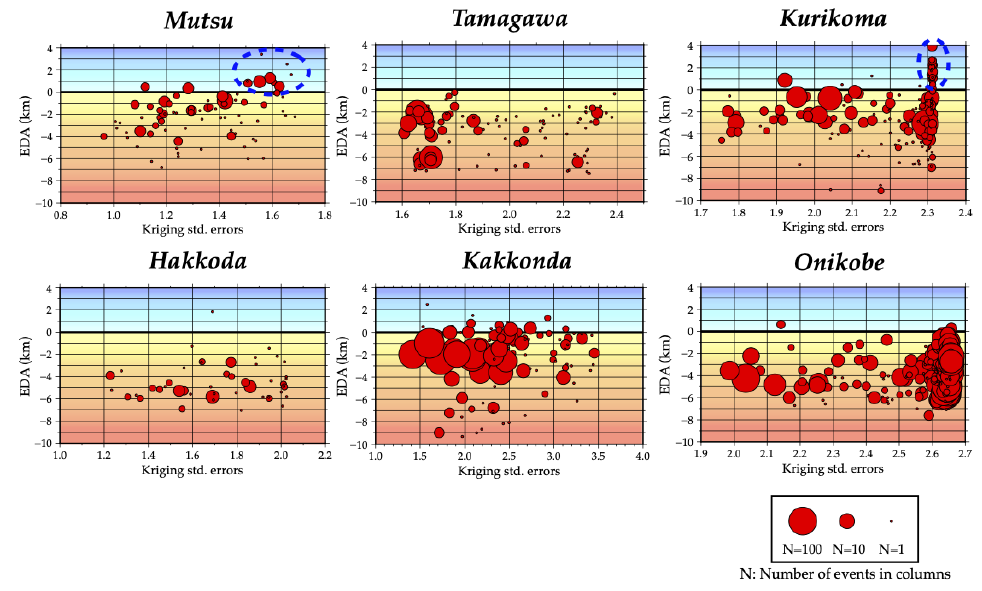
Figure 8. R elation between the EDA and kriging standard error. The size of the red circles shows the number of seismic events in each